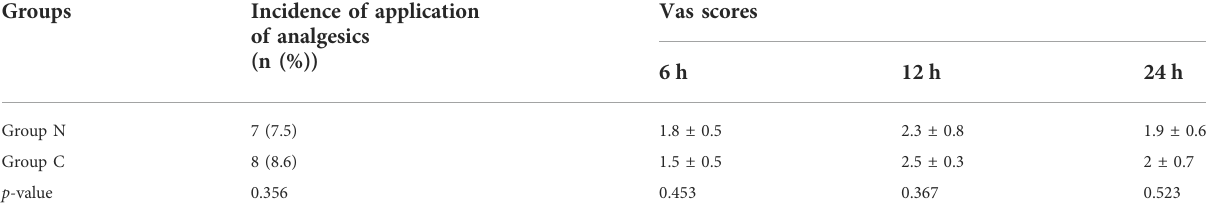
TABLE 7 Comparison of the VAS score and incidence of application of analgesics within 24 h after operation between the two groups (n (%)). Groups